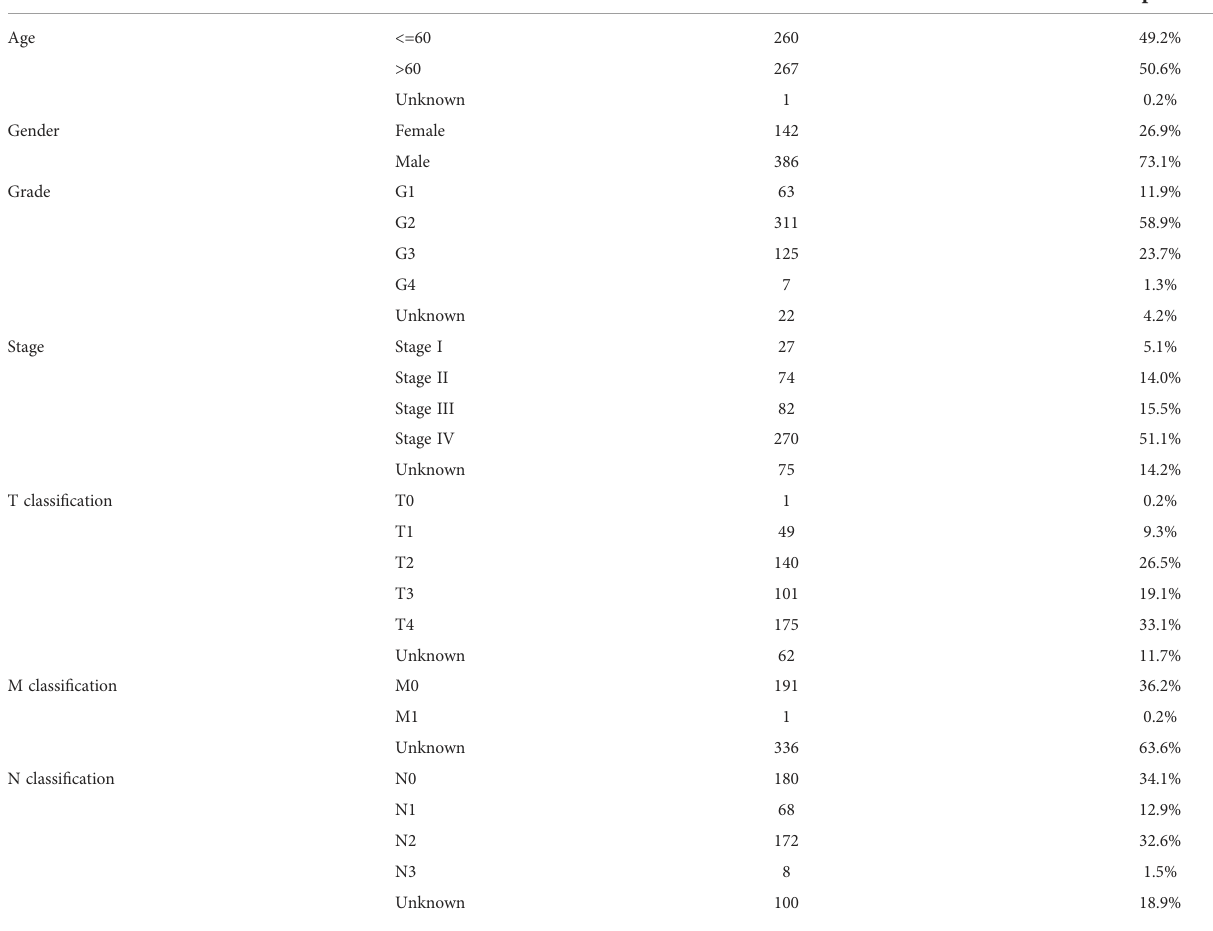
TABLE 1 The baseline data of